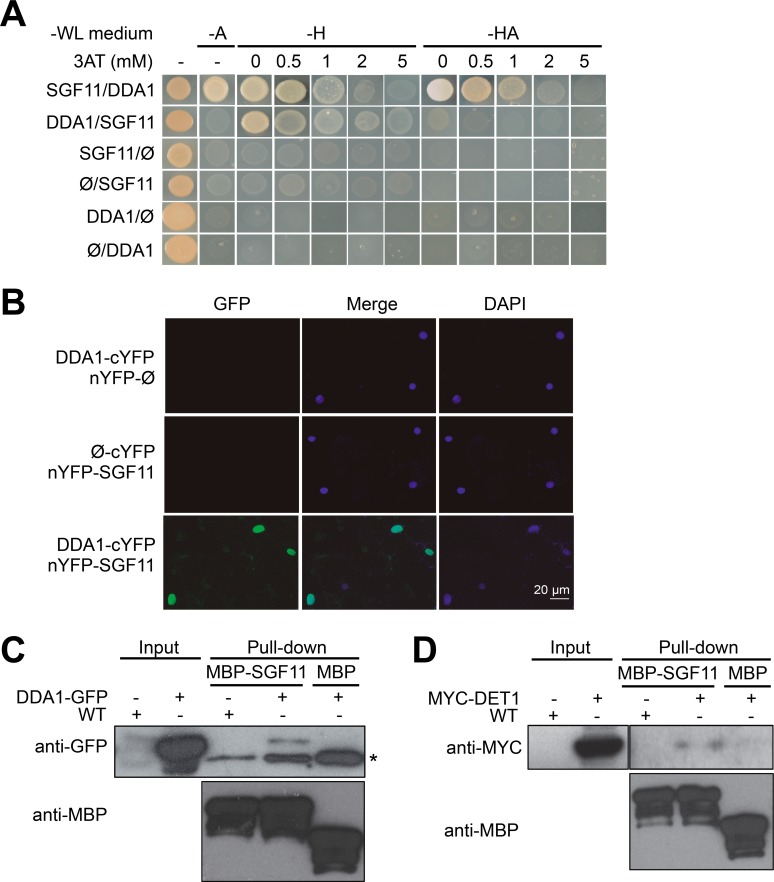
DDA1 C3D subunit physically associates with SGF11.(A) Yeast-two-hybrid validation of DDA1-SFG11 interaction identified by Y2H screen. (B) BiFC analysis of DDA1 physical interaction with SGF11 in planta. Live fluorescence imaging 72 hr after dual transfection of Nicotiana leaves by plasmids expressing the indicated translational fusions. Merged images of GFP (left) and DAPI (right) channels are shown (middle). (C–D) DDA1 and DET1 associate with the SGF11 in plant extracts. Pull-down assays were performed using total protein extracts prepared from 7-d-old seedlings expressing DDA1-GFP (C) or MYC-DET1 (D) protein fusions with MBP-SGF11. Protein extracts (Input; 2% of the total amount used) and pull-down proteins were subjected to immunoblot analysis with anti-GFP, anti-MYC and anti-MBP to detect the corresponding fusion proteins. In (C), an asterisk indicates the position of an anti-GFP cross-reacting signal.